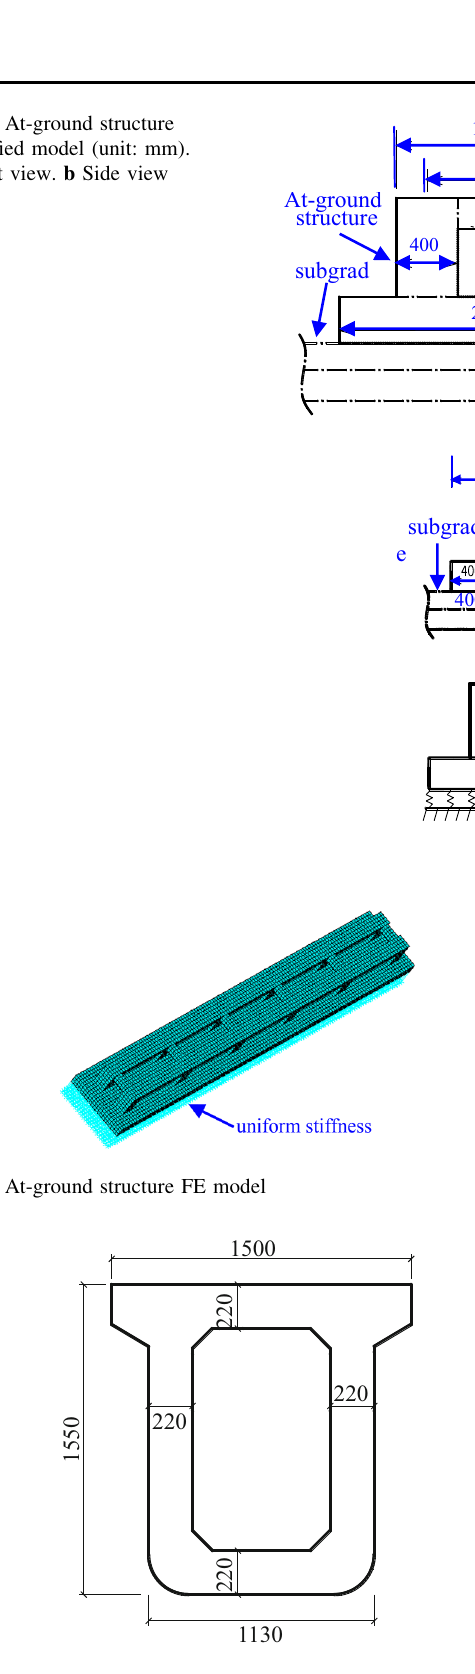
Fig. 4 Cross section of 20-m simply supported beam (unit: